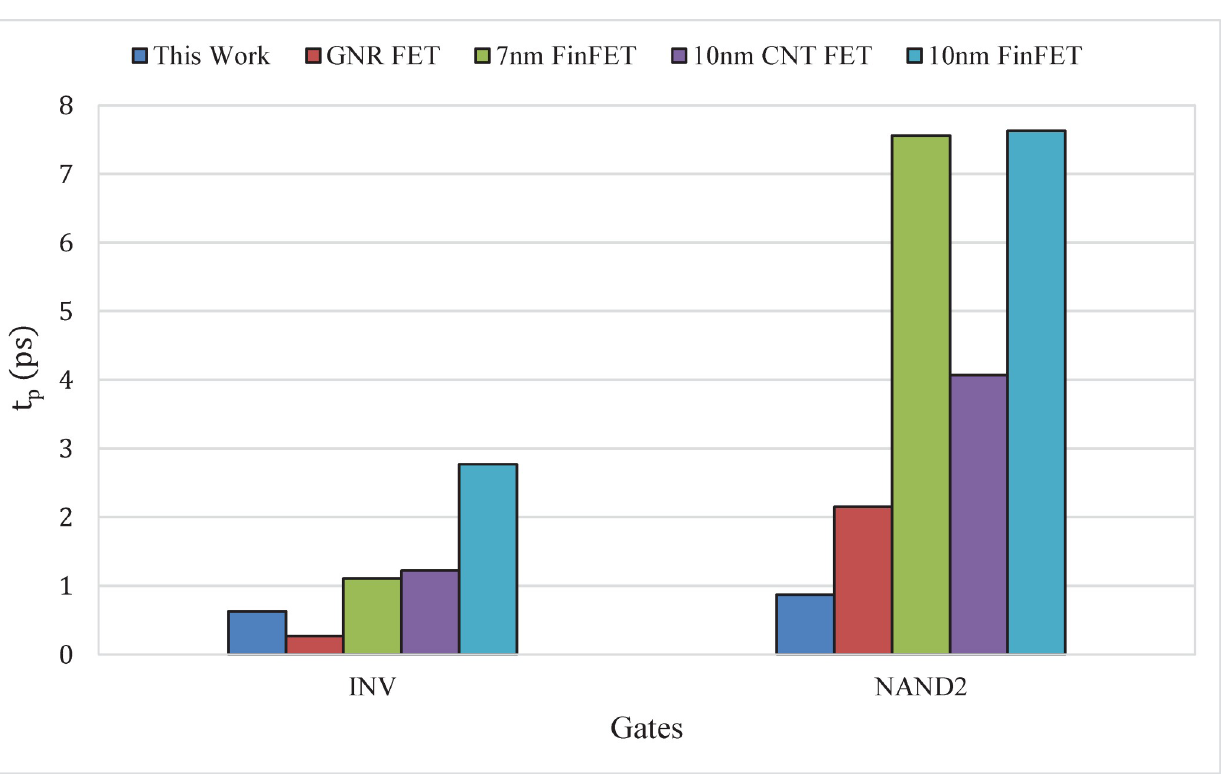
Fig 10. Comparison of propagation delay ( t ) between the proposed silicene-based logic circuit with recent published results. INV and NAND2 p represent inverter and 2-input NAND gates, respectively.